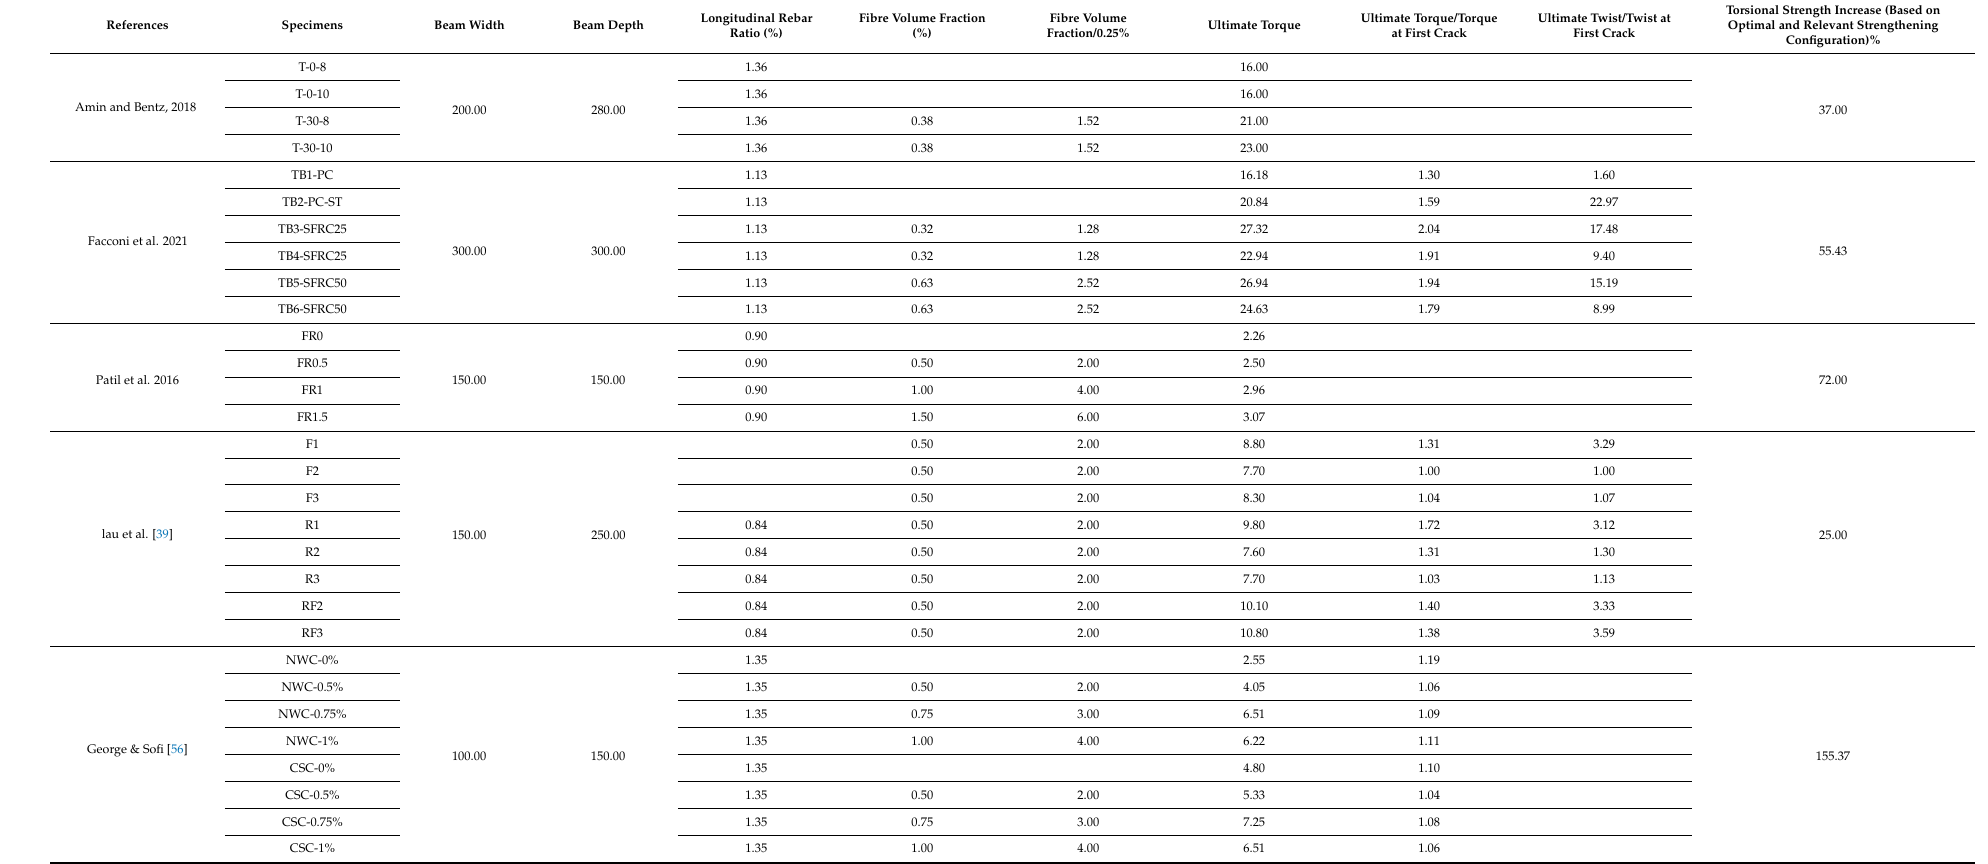
Table 7. Comparison of different experimental studies for steel fibre reinforced